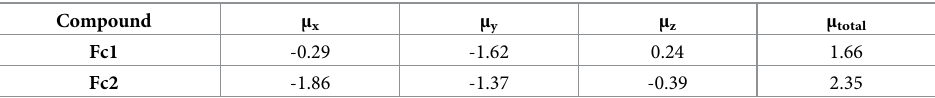
Table 5. The calculated dipole moments (Debye) for all compounds at B3LYP/6-311G++(d,p) level of theory.